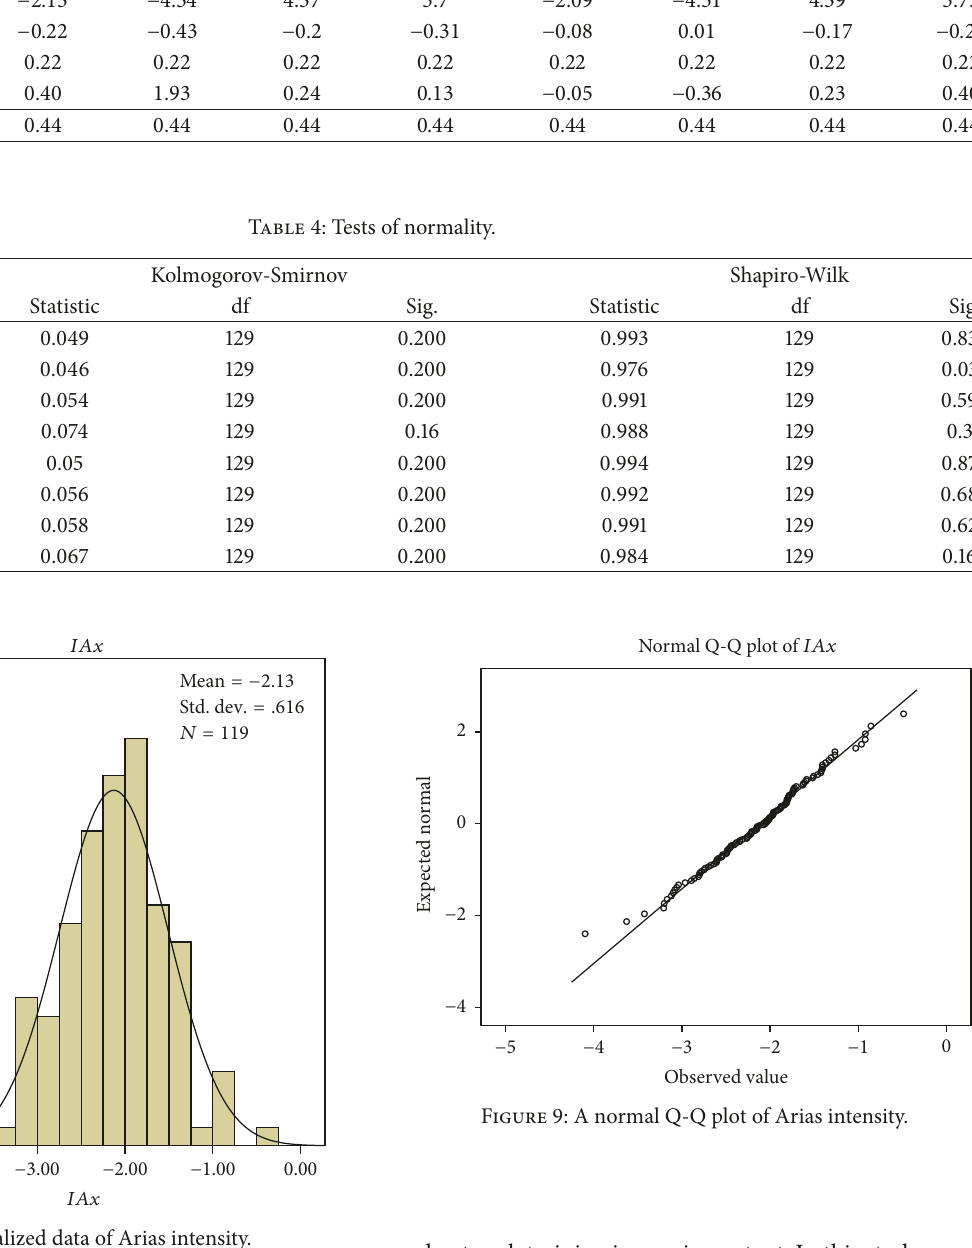
Figure 8: Normalized data of Arias intensity.